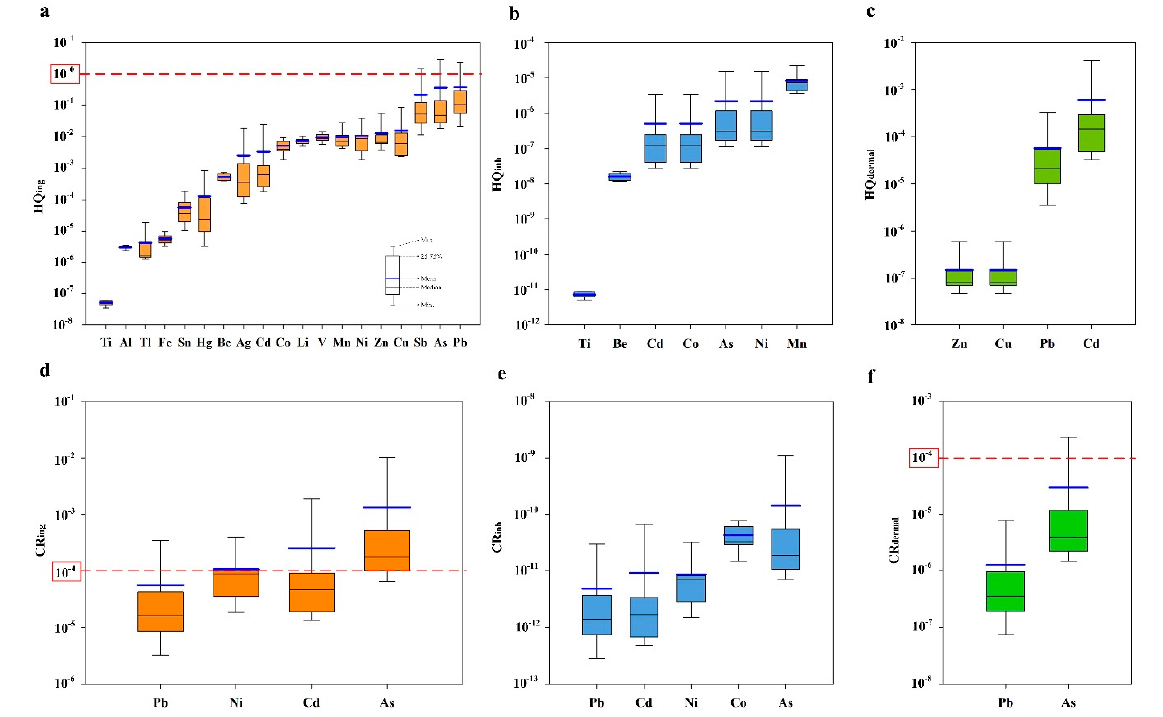
Figure 4. Non-carcinogenic risk and carcinogenic risk through ingestion, inhalation, and dermal contact with exposure of HMs from PM10 in RDS, Red line is the acceptable level (HQ ing < 1 (10 0 ), CR ing < 10 − 4 ). ( a ) HQ ing , ( b ) HQ inh , ( c ) HQ dermal , ( d ) CR ing , ( e ) CR inh , ( f ) CR dermal .